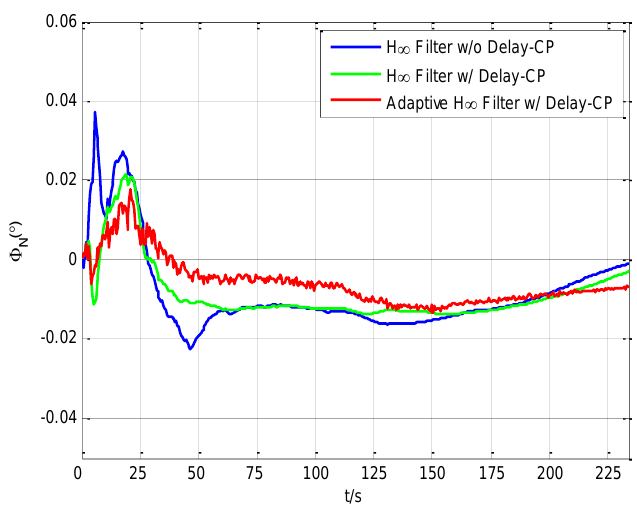
Figure 11. The estimation curves of north misalignment angle.